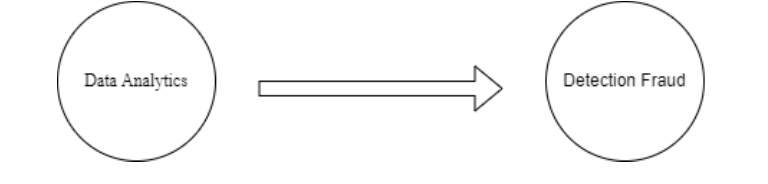
Figure 1: Conceptual Model of the Study; Source : Data Processing,